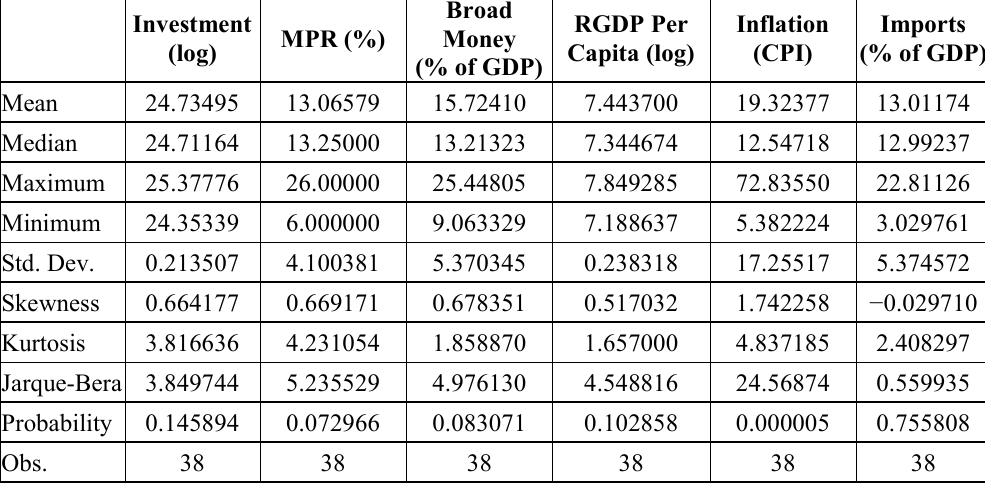
Table 1. Summary Statistics (Sample: